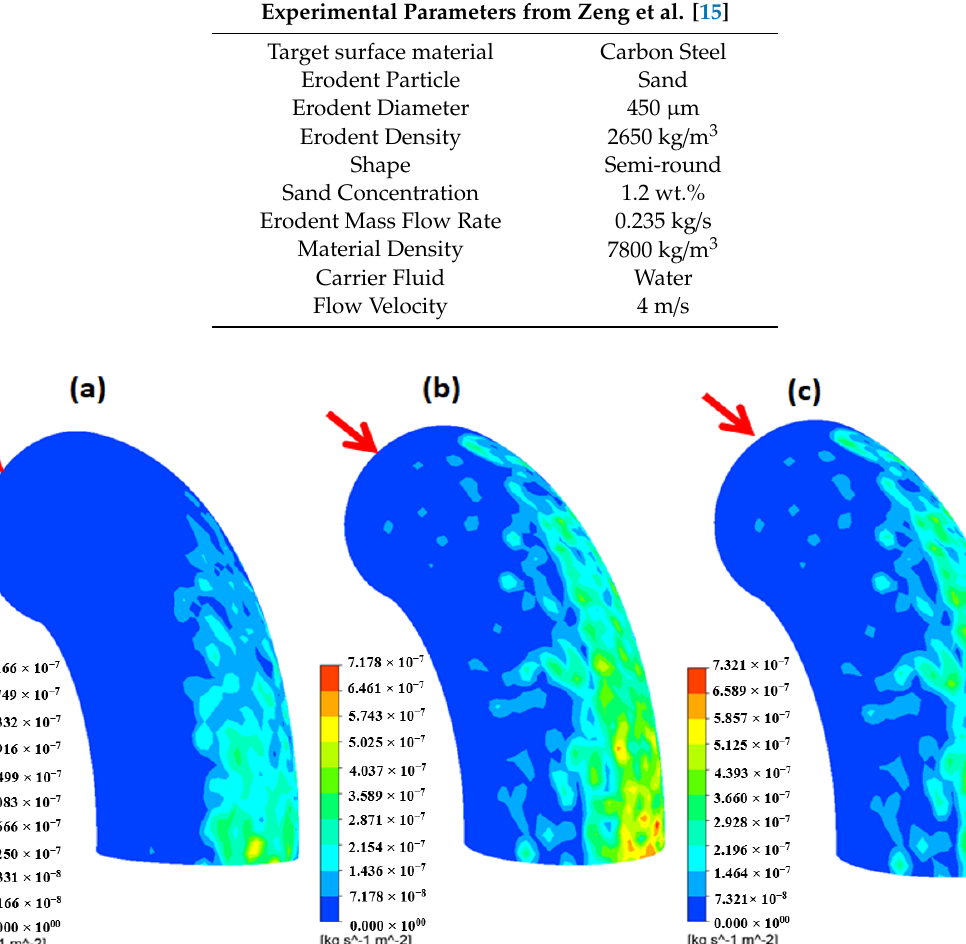
Figure 9. Comparison of numerical and experimental erosion rates along the elbow outer wall for the three different mesh sizes.